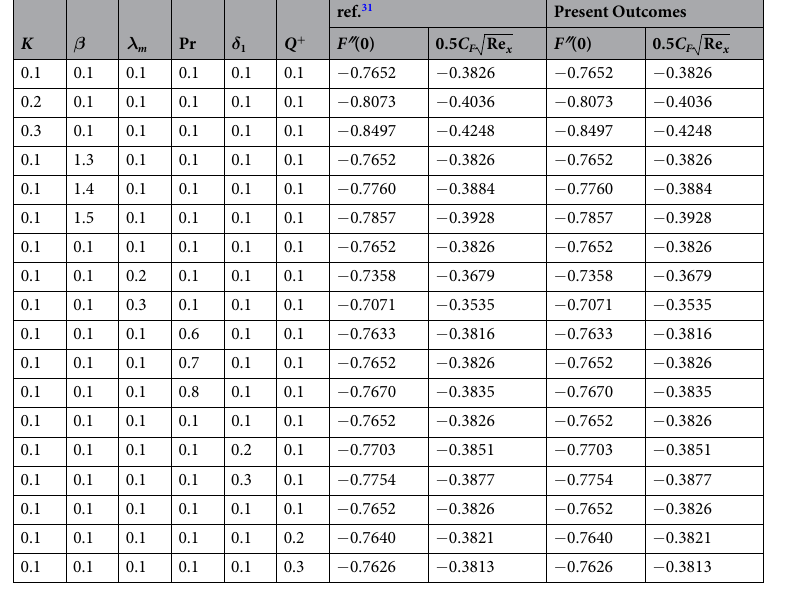
Table 1. LSFC comparison with ref. 31